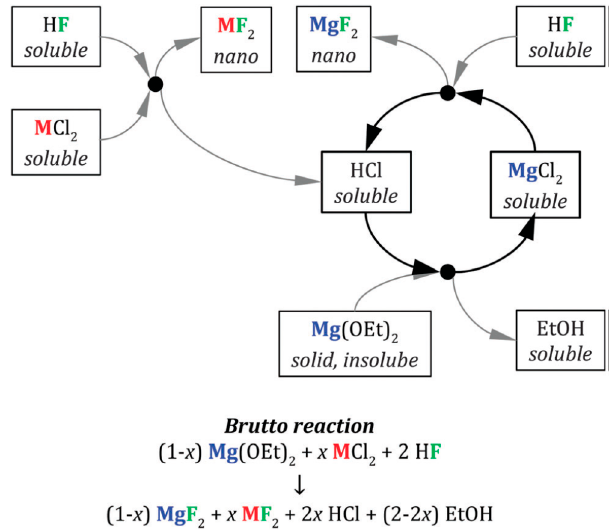
Figure 8. Schematic representation of the reactions occurring during the one-pot synthesis using the chloride method (M = Mg, Ca; x = 0.05–0.30; Et = C 2 H 5 ). Reproduced from Reference [40] with the permission of the Royal Chemical Society.